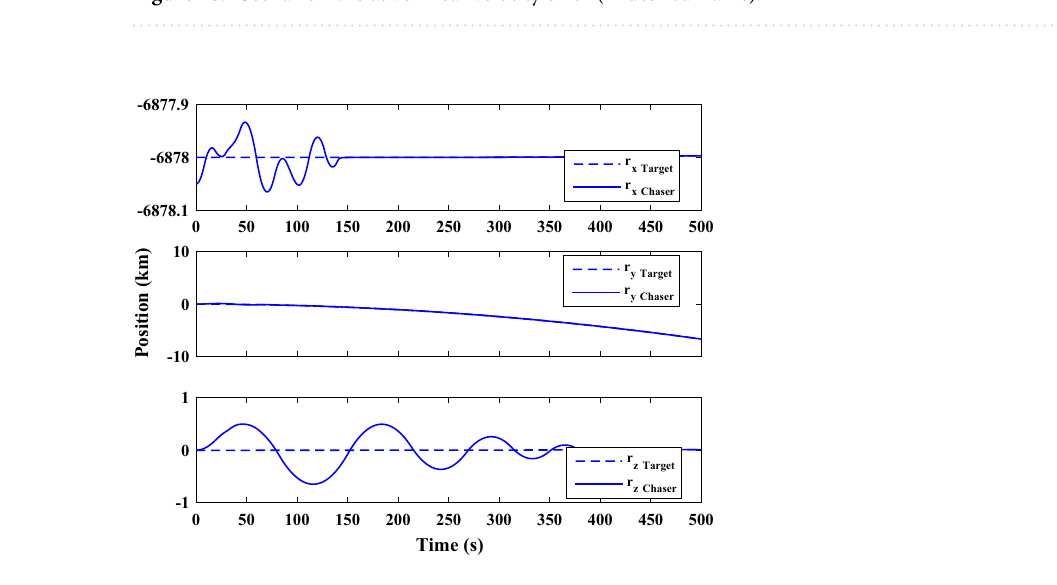
Figure 41. Scenario II: position tracking (in desired frame).